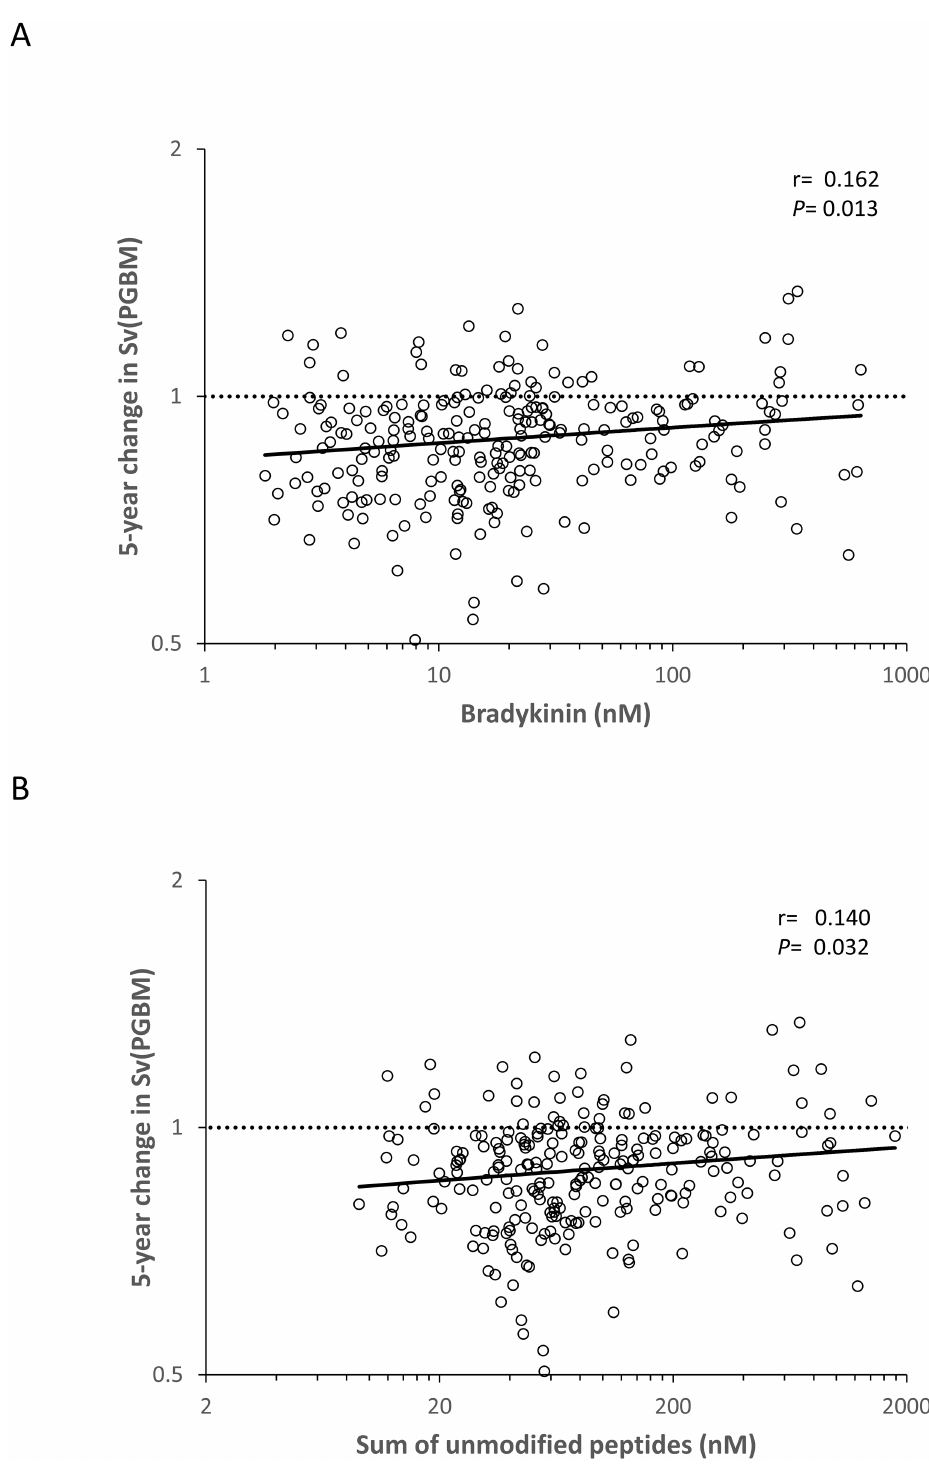
Fig 2. Associations of baseline plasma BK and the sum of all unmodified bradykinin peptides with the ratio (5-year/baseline) of Sv(PGBM/glom) in the 243 RASS participants. Residualswere computed by regressing each of the variableson sex, baselineage, durationof diabetes,HbA1c, mean arterial pressure, treatment assignment, and baselineSv(PGBM/glom). Residualsare plotted on logarithmicscales. Values abovethe dashed line reflect an increasein Sv(PGBM/glom) and those belowthe line a decrease over 5 years.